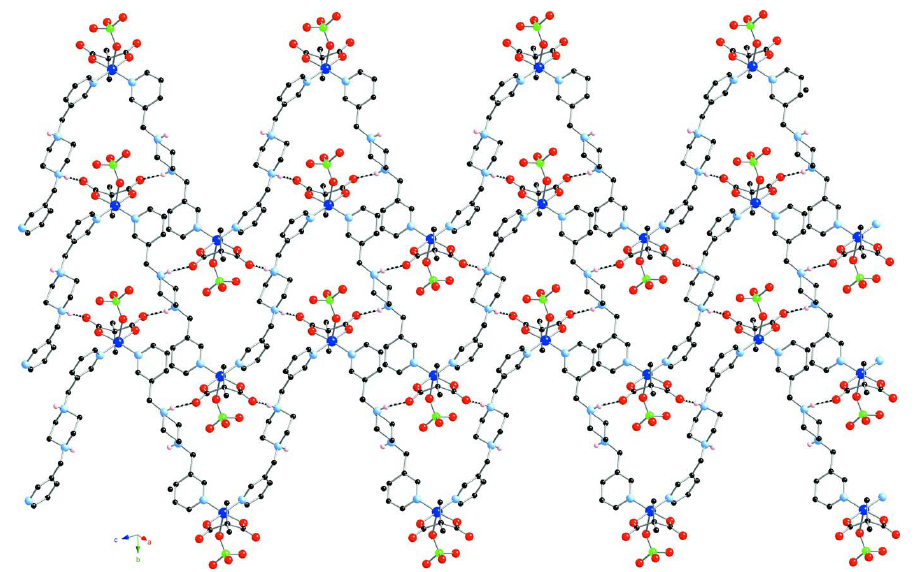
Figure 3 A supramolecular [Cu(dimethylmalonate)(ClO